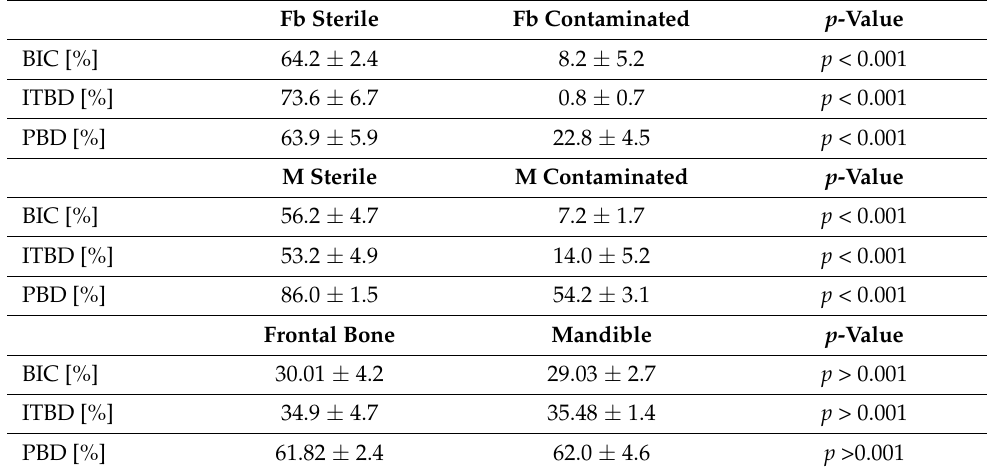
Table 2. Comparative assessment of BIC, ITBD, and PBD values in both groups showed no significant differences between implants placed in frontal bone and